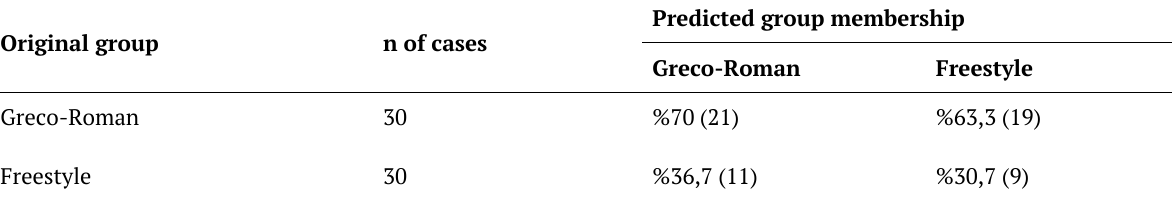
Table 5. Classification of groups according to the discriminant function